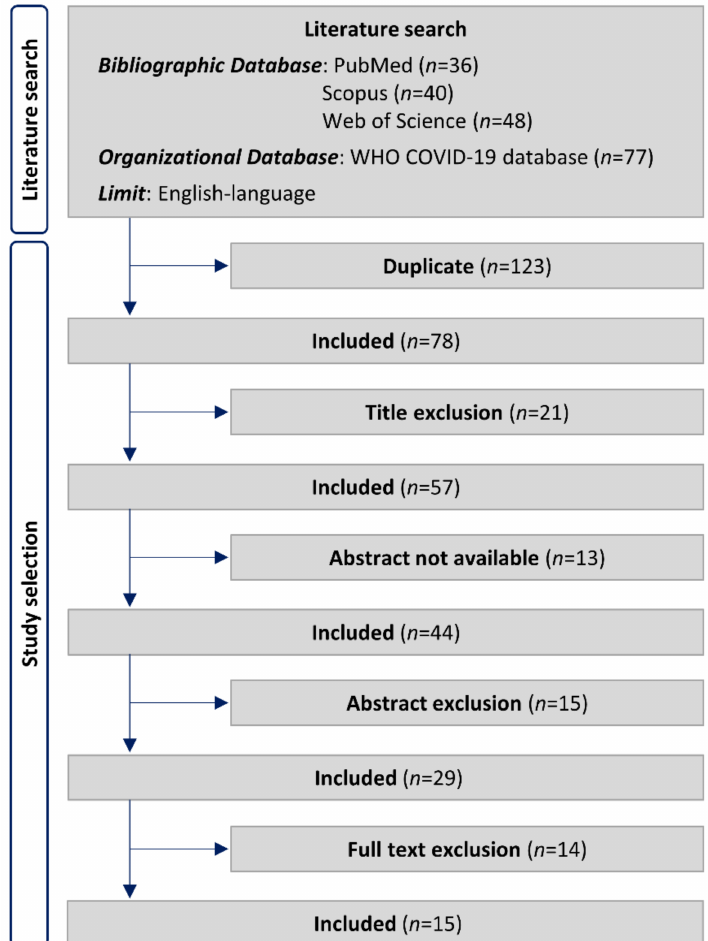
Figure 1. Performed literature search and study selection.